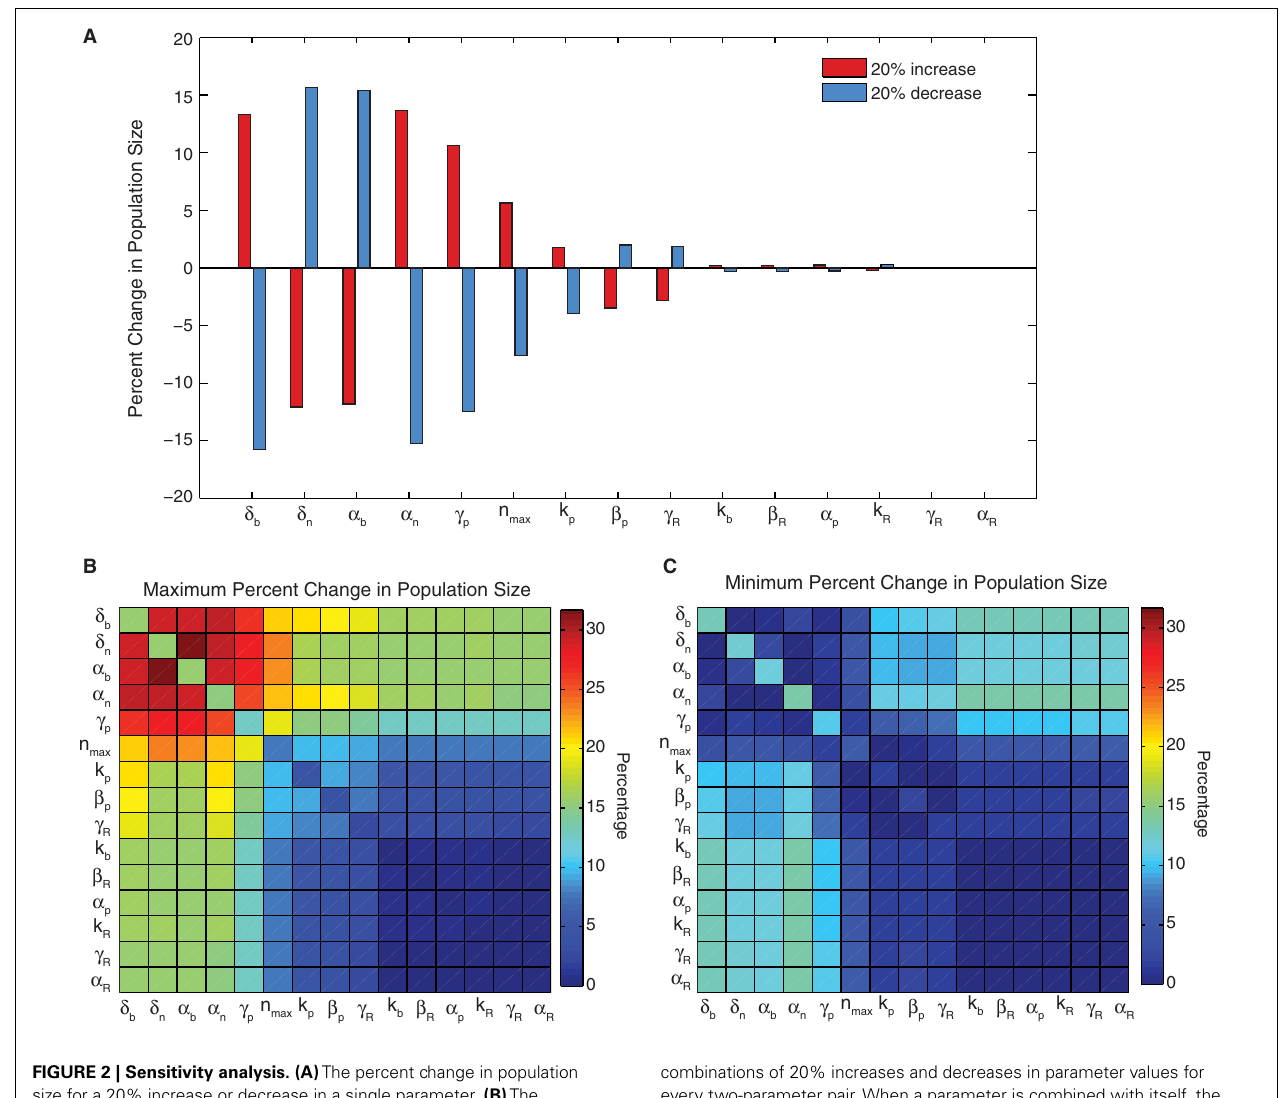
FIGURE 2 | Sensitivity analysis. (A) The percent change in population size for a 20% increase or decrease in a single parameter. (B) The maximum change and (C) minimum change observed for all four